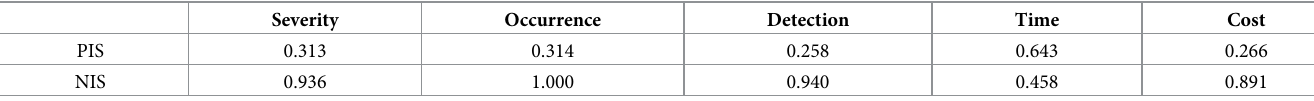
Table 6. The PIS and NIS of the rough weighted normalized matrix.